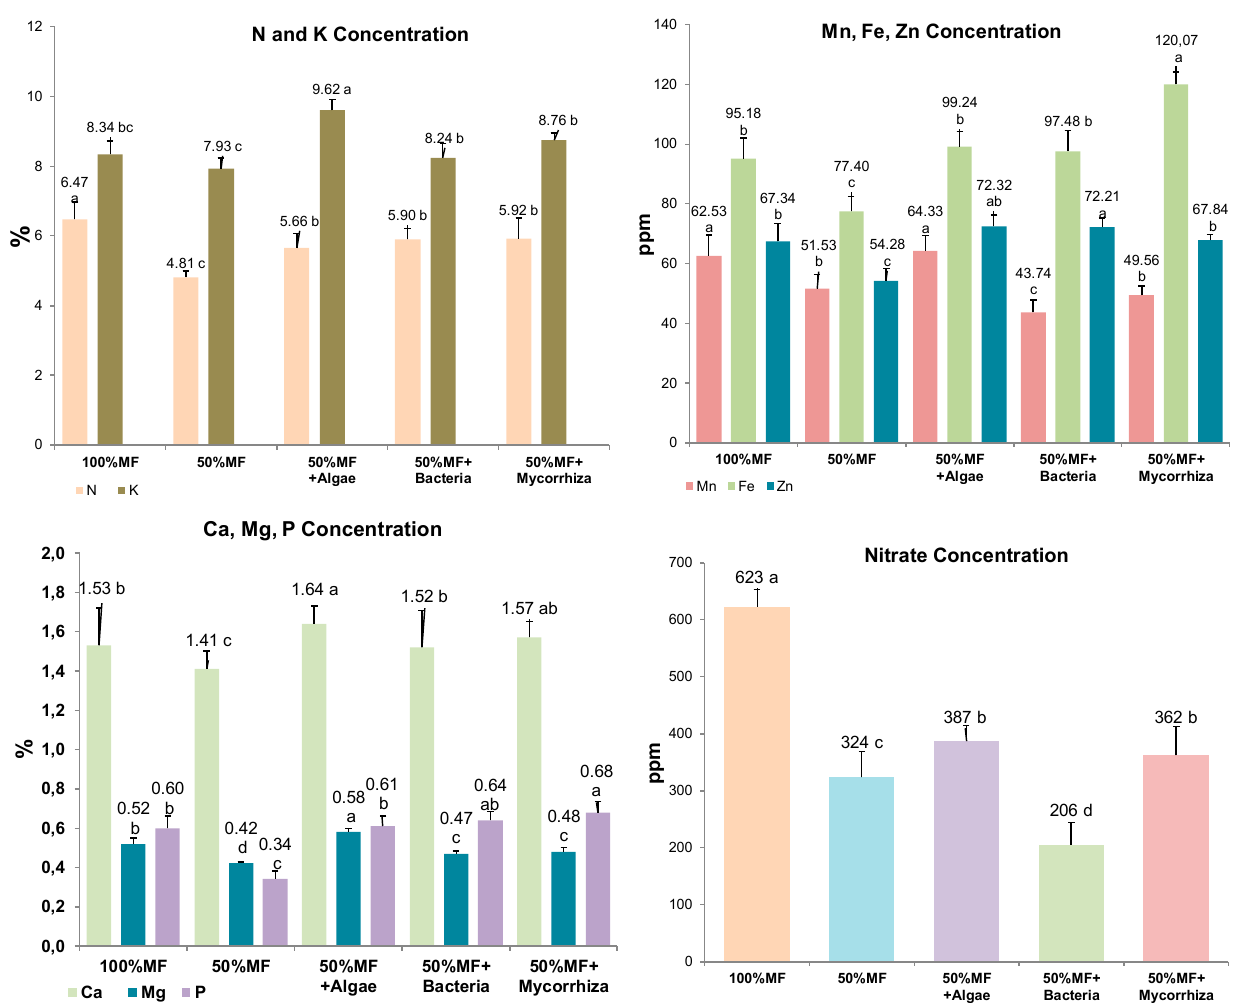
Figure 6. Effects of supplemental biofertilizers on baby spinach leaf macro N, P, K, Ca, K (%), micro Fe, Mn, Zn (mg kg − 1 ) nutrient concentrations and nitrate (mg nitrate kg − 1 FW) content. FW: fresh weight. There is no significant difference between means with the same letter in the same color histogram.